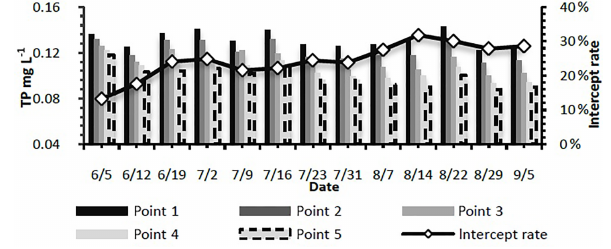
Figure 4. Change laws of the total nitrogen. Figure 5. Change laws of the total phosphorus.